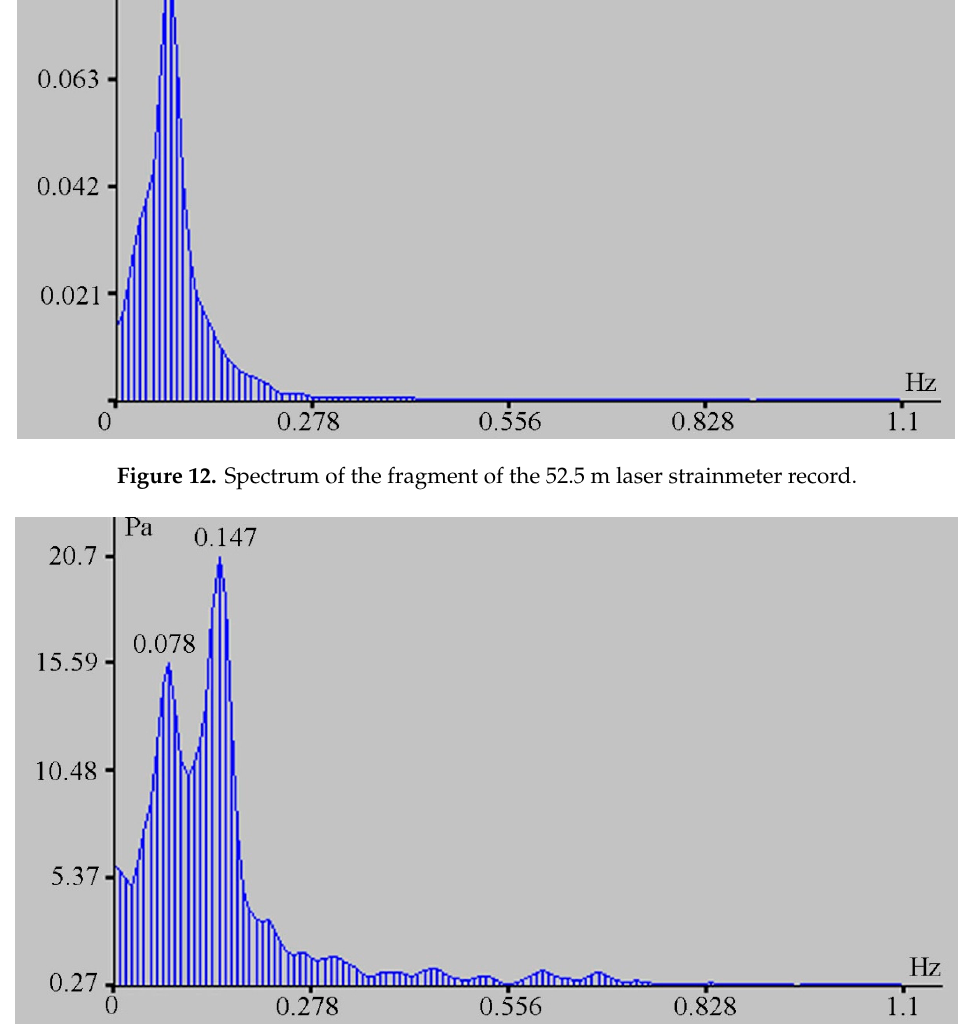
Figure 13. Spectrum of the record fragment of the supersensitive detector of hydrosphere pressure